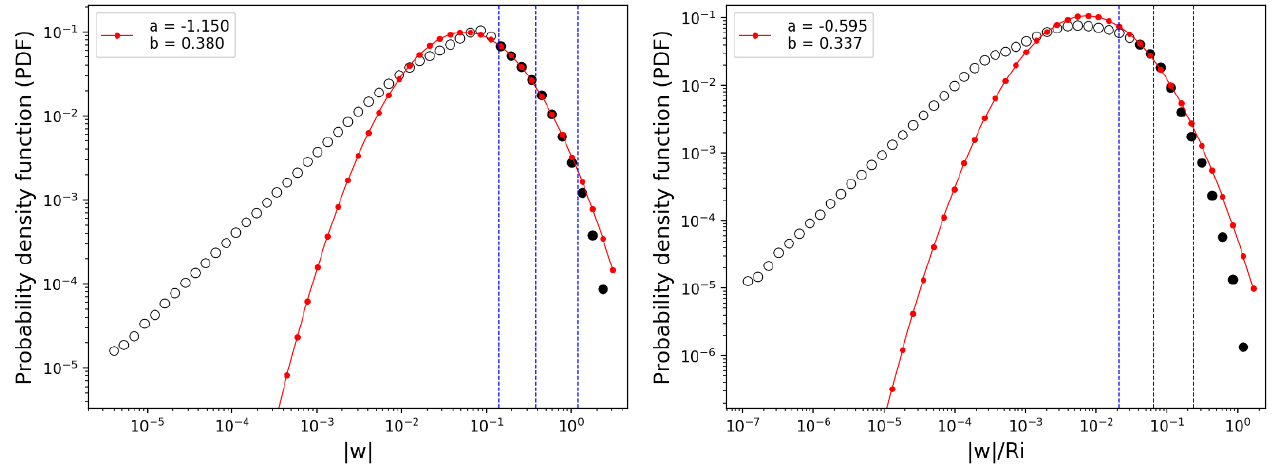
Figure 14. As in Figure 7, except for the PDFs of the absolute vertical velocity |w| (left) and |w| divided by the Richardson number (|w|/Ri). The PDFs were calculated from a 1 h model output of 28 October 2018. The coefficients of the best fit curve are indicated in the upper left side.